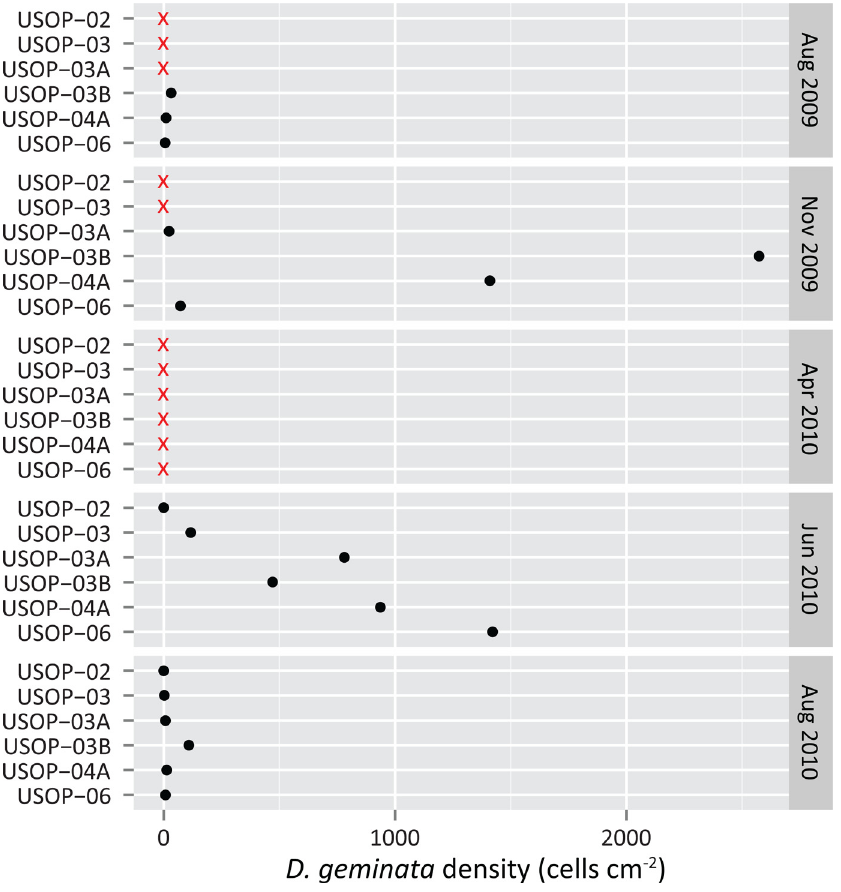
Fig 5. Cell density of D . geminata plotted by site and month showing a possible upstream range expansion. Black dots indicate cell density > 0 and red “ x ” s indicate a